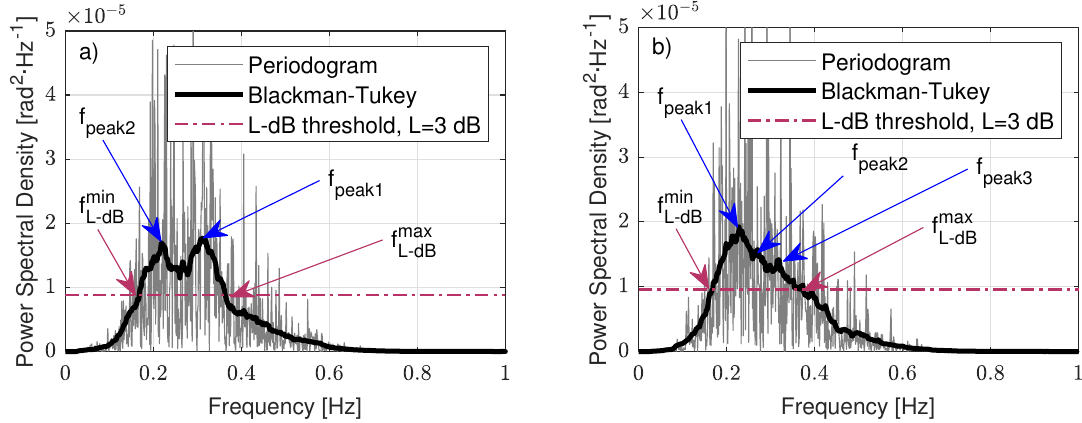
Figure 7. Two examples of power-spectral-density (PSD) estimation by periodogram and Blackman–Tukey method of measured tilt data: ( a ) bimodal case and ( b ) multimodal case. The L-dB threshold and cutoff frequencies, f min are also indicated by magenta dashed lines and arrows. L = 3